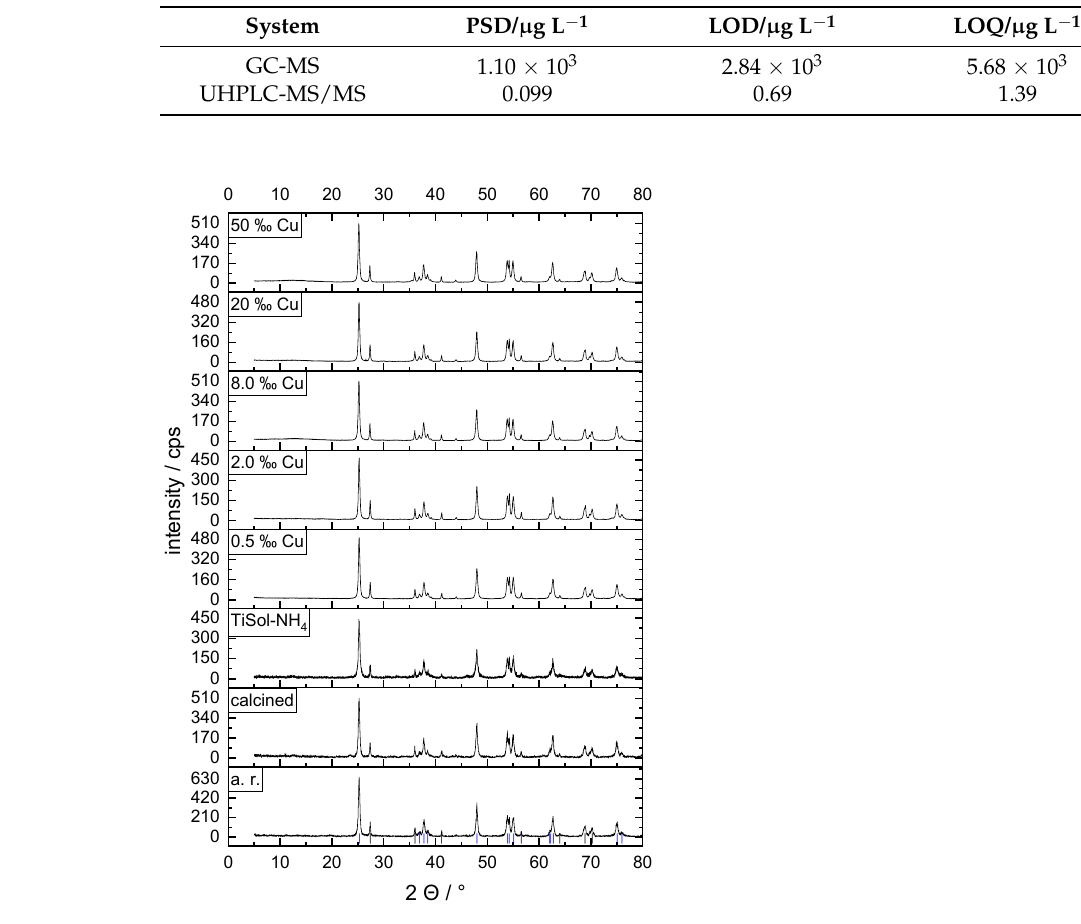
Table 1. Values for process standard deviation (PSD), limit of detection (LOD) and limit of quantita- tion (LOQ) in reference to Figures 1 and 2; according to DIN 32645.